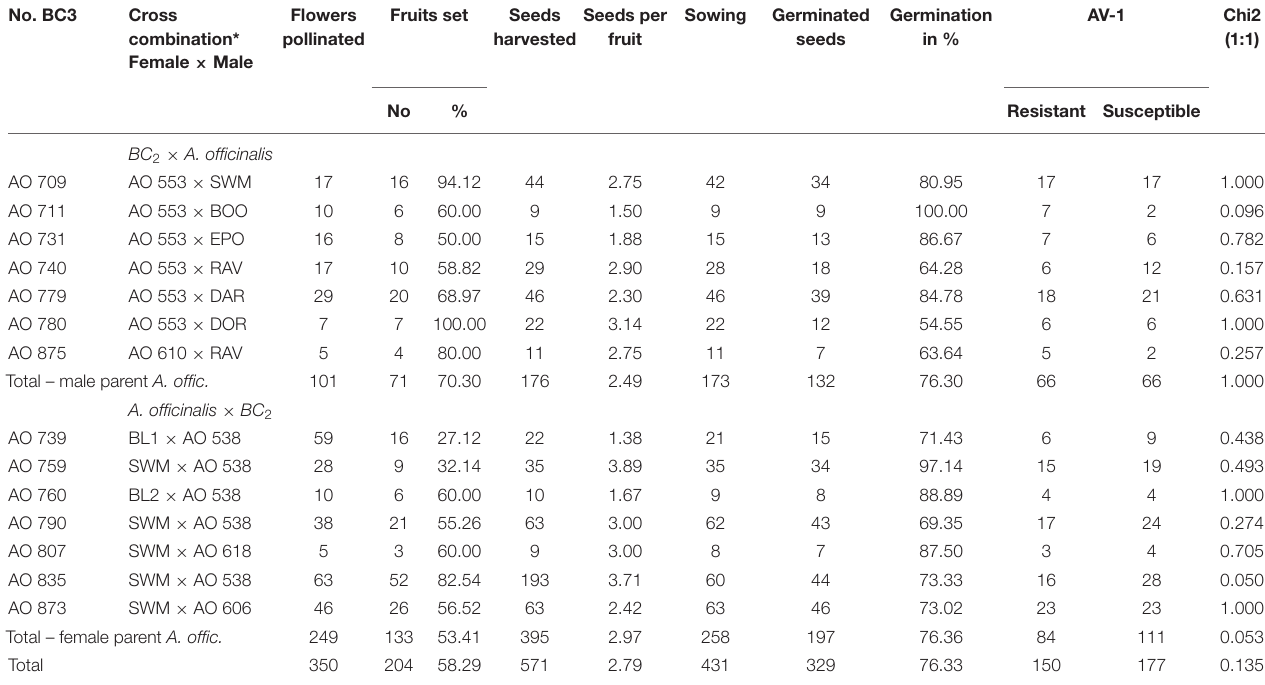
TABLE 1 | Results of the BC 3 crossing experiment, the resistance test, and the segregation analysis. No.